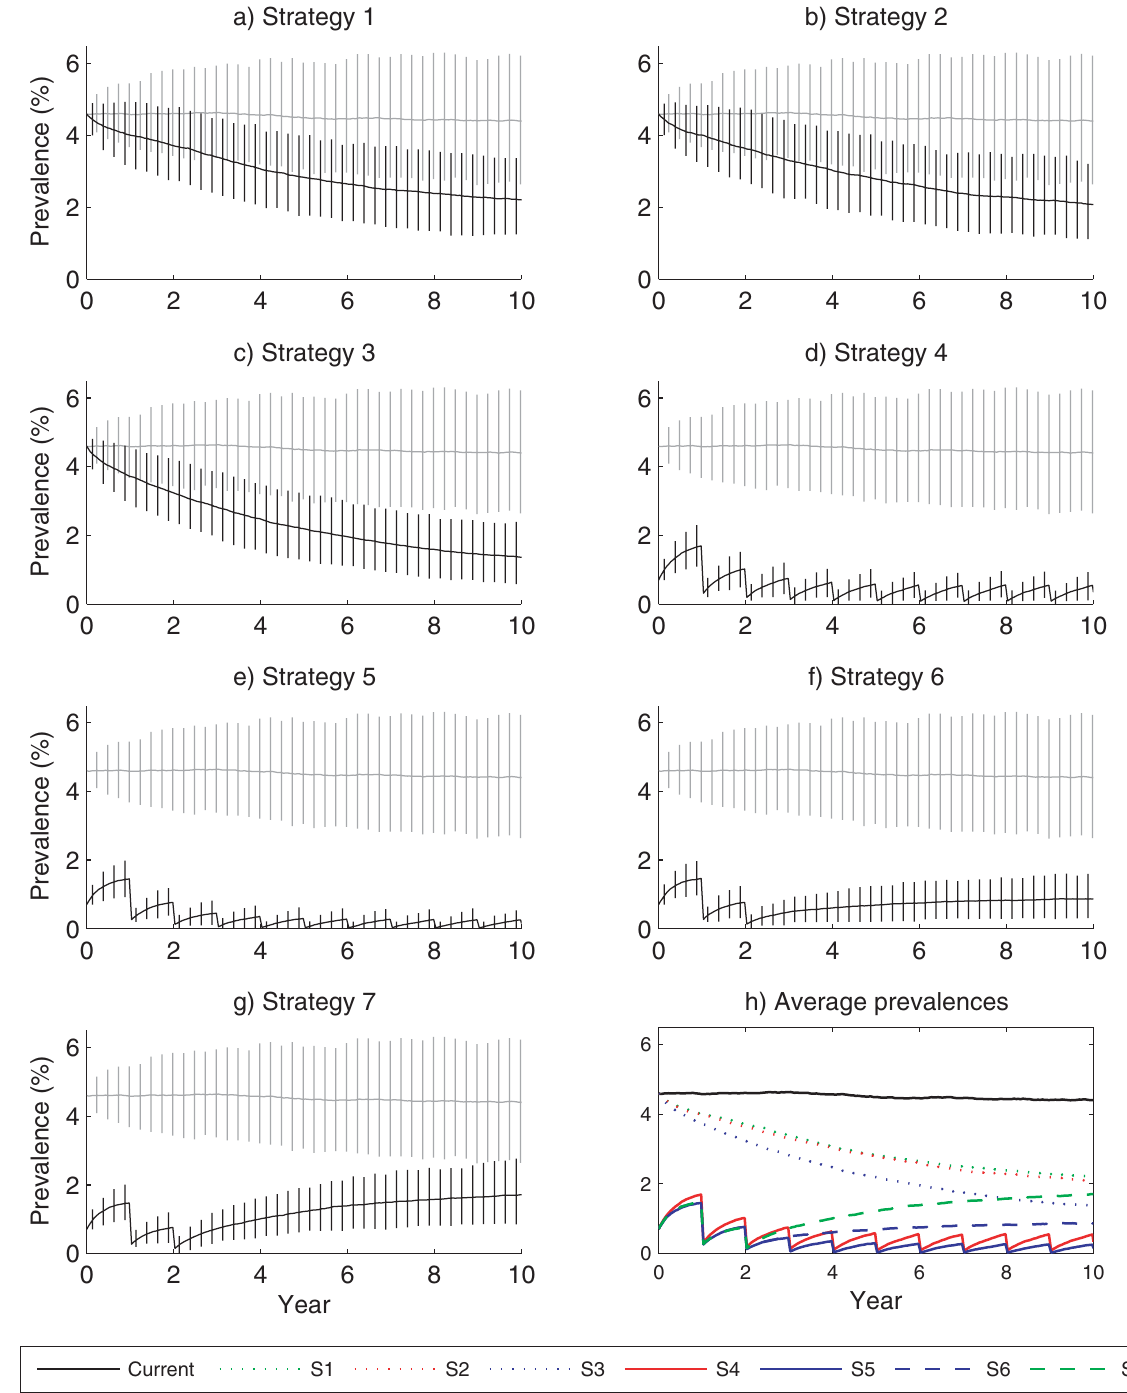
Figure 2. Predicted prevalence (%) of active TB. Simulations are performed over a 10 years period for the seven strategies (black lines) and for the current scenario (grey lines). The continuous line represents the mean of the prevalence on 600 simulations and the vertical line extremities represent percentiles 5 and 95.